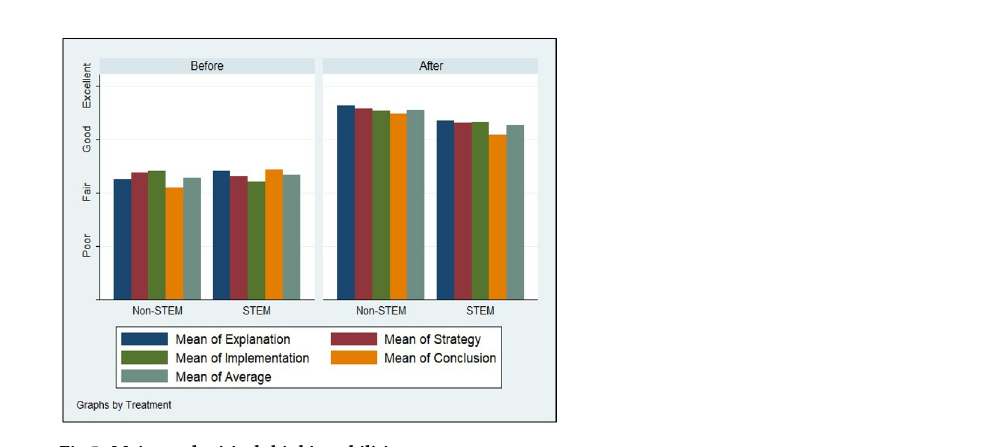
Paired Samples Statistics